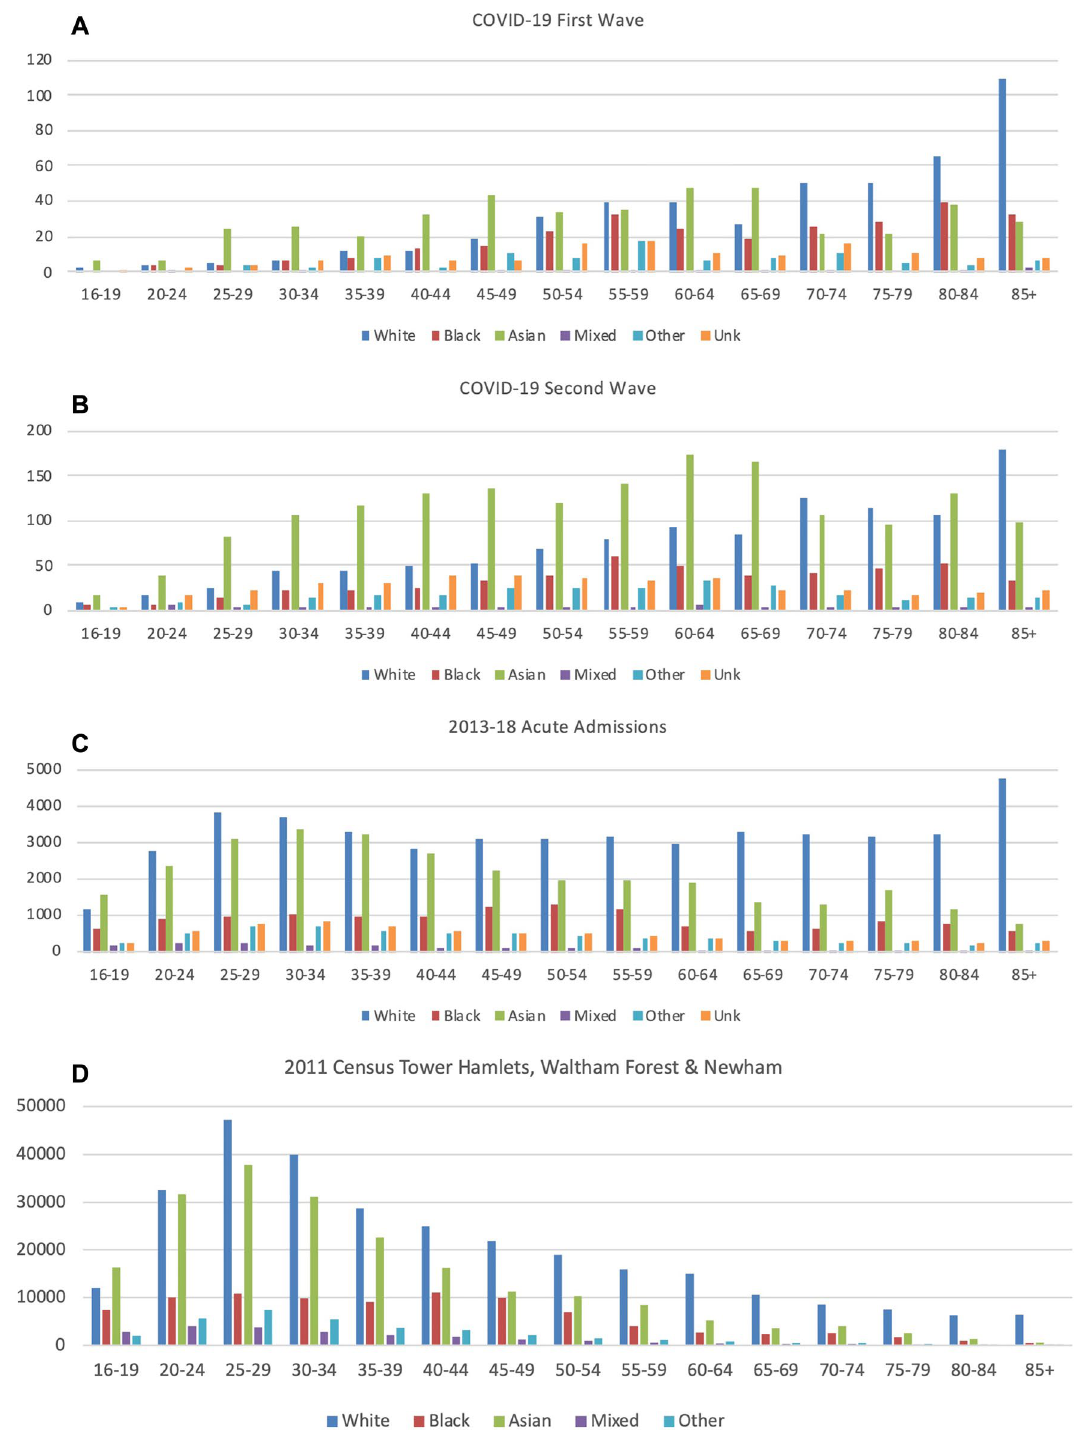
Figure 4. Numbers of first admissions to Barts Health hospitals in residents of the London Boroughs of Tower Hamlets, Newham, and Waltham Forest aged ≥ 16, grouped by age and ethnicity for the first and second waves of COVID-19 (panels A & B ) or any acute admissions during 2013–18 (panel C ). Age and Ethnicity distribution of the Tower Hamlets, Newham, and Waltham Forest population in the 2011 UK Census is shown for comparison (panel D